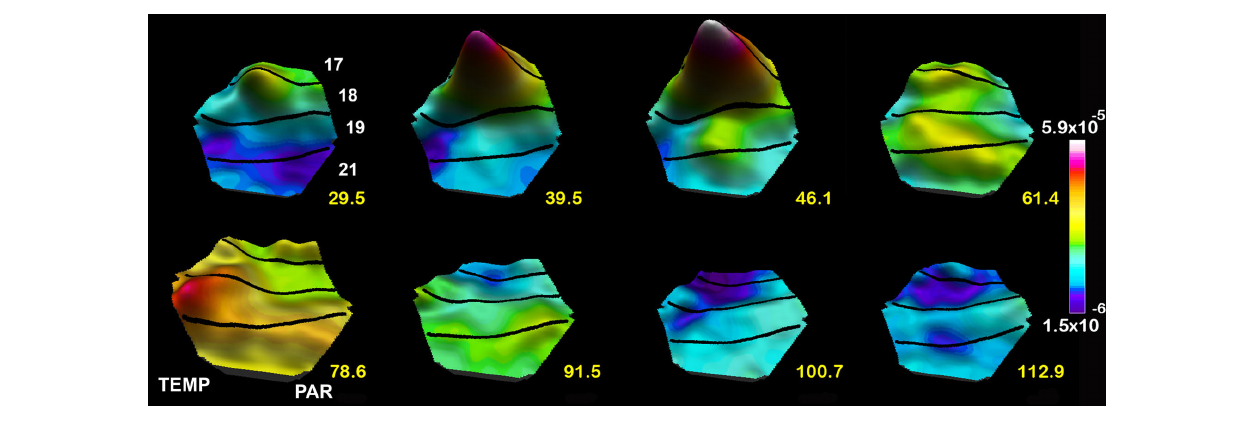
excitation from the center of both bumps, the FB 61.4–78.6 ms, the /d t in response to a m lateral spreading inhibition (negative d V /d t ) spreading out first from the m 17/18 mapping site and then from the 19/21 area mapping site 91.5 ms to 112.9